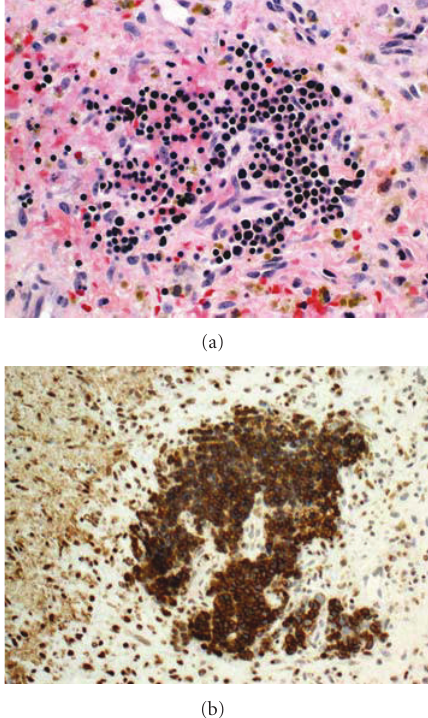
Figure 1: EMH within subdural hematoma. (a) Clusters of small round cells with hyperchromatic round nuclei and scant cytoplasm in a background of connective tissue with acute and chronic hemorrhage (H and E × 400). (b) The small round cells show strong immunoreactivity for glycophorin A, a marker for erythroblastic line cells (glycophorin A ×